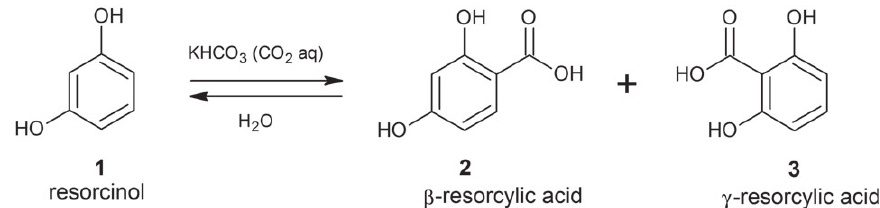
Figure 2 Reaction scheme for the synthesis of β -resorcylic acid (2,4-dihydroxybenzoic acid) from